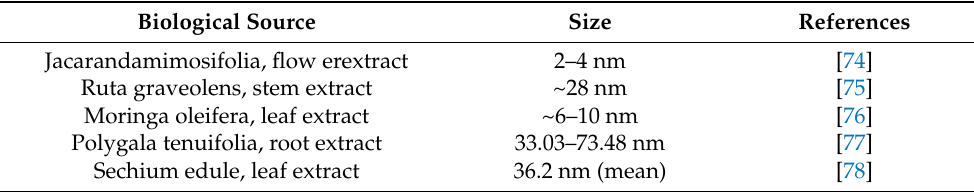
Table 2. Green synthetic sources of varying sizes of spherical ZnONPs.